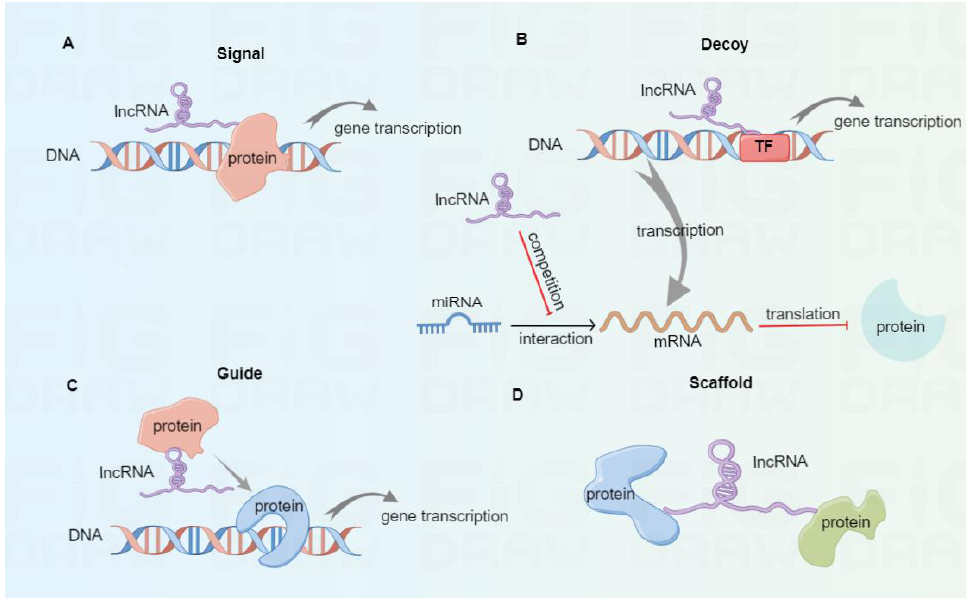
Figure 1. The classification of lncRNAs based on molecular mechanisms. ( A ) Signal lncRNAs can modulate downstream gene transcription independently or by interacting with proteins. ( B ) Decoy lncRNAs serve as decoys of transcription factors or ceRNAs to bind with miRNAs, thus eliminating their inhibitory effect in mRNA translation. ( C ) Guide lncRNAs can bring protein complexes to target sites to promote gene transcription. ( D ) Scaffold lncRNAs serve as scaffold molecules to interplay with multiple protein